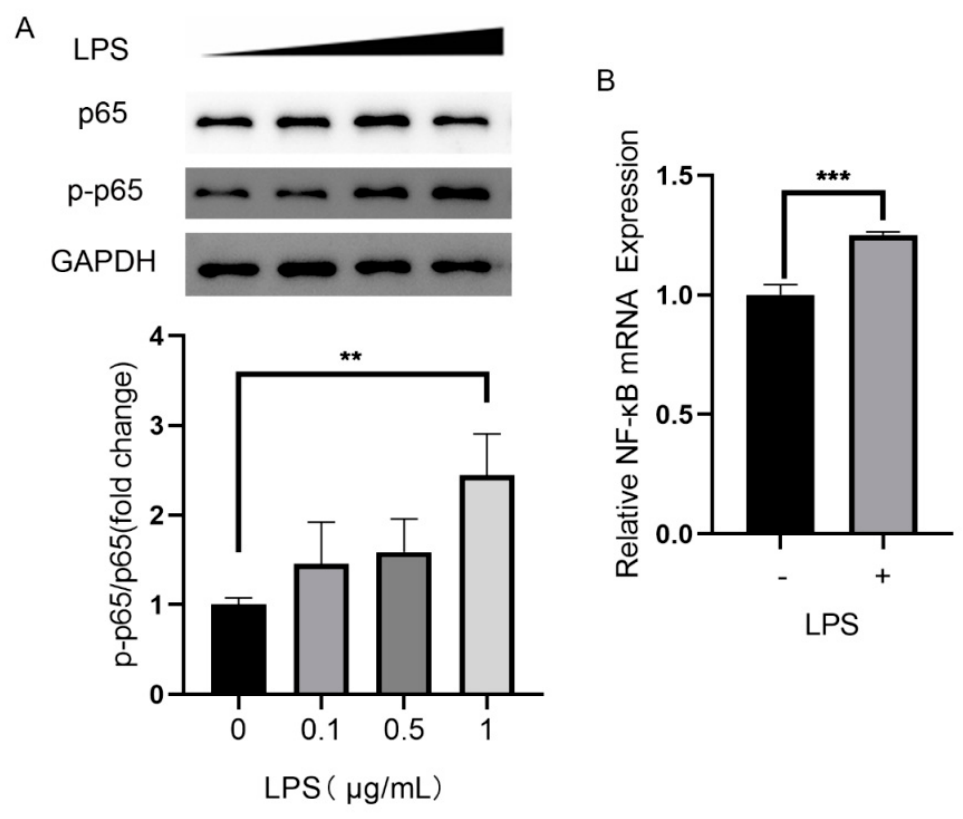
Figure 2. Effect of LPS on the expression of NF- κ B and p-p65 protein in ARPE-19 cells. ( A ) Protein level of p65 and p-p65 with LPS treatment. ** p < 0.01. ( B ) mRNA level of NF- κ B after LPS stimulation. *** p < 0.001.